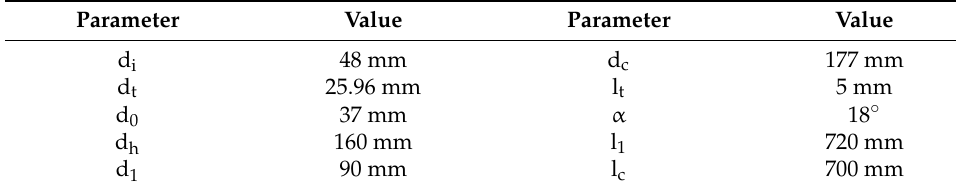
Figure 2. Variation curve of entrainment ratio with each structural size of the ejector. Table 3. Final geometric parameters of the ejector optimized by the single factor.